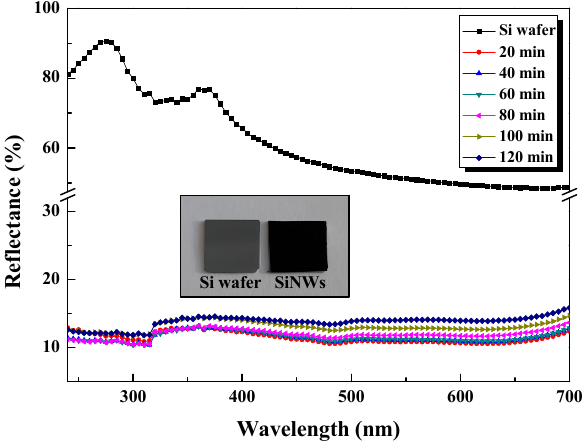
Figure 10. Reflectance spectra of SiNWs with various lengths etched during different times and corresponding Si wafer. The inset displays images of Si wafer and SiNWs. When compared to the untreated bulk Si, all the etched samples show a significant lower reflectivity which is consistent with the colour changes from metallic grey to dark black as shown in the inset. The average reflectance for bulk Si is about 50%~90% in the UV–visible range while it reaches less than 15% for all the etched samples. Hence, such nanowires reduce reflection losses and